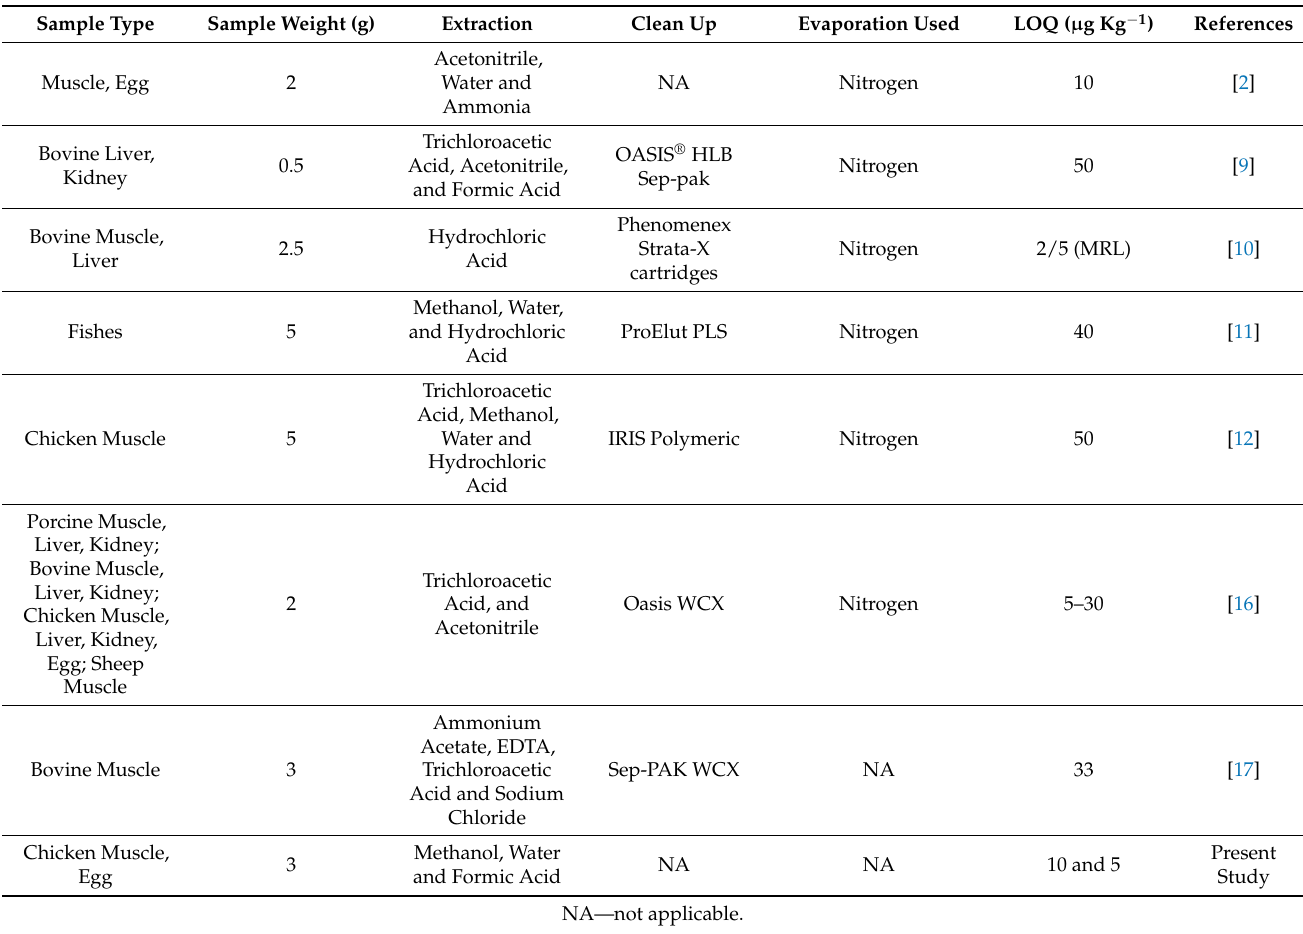
Table 3. Comparison of earlier reported sample preparation protocols used for colistin B detection with newly proposed protocol. Sample Type